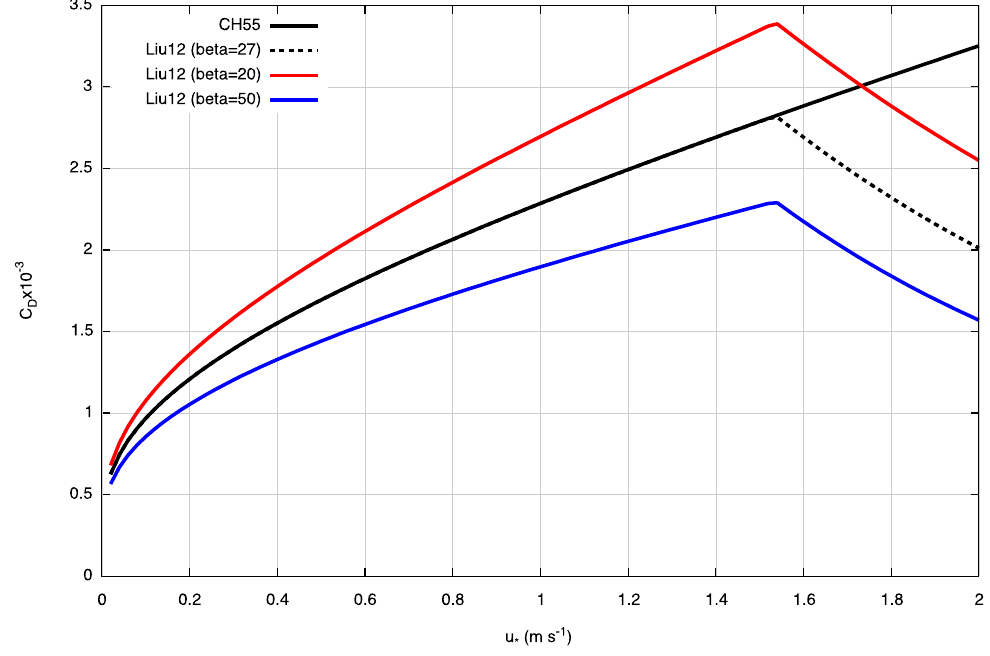
Figure 3. Drag coefficient formulations. Charnok (1955): continuous black line. Liu et al. [26,27]: for β = 20, continuous red line; for β = 27, dotted black line; for β = 50, continuous blue line.